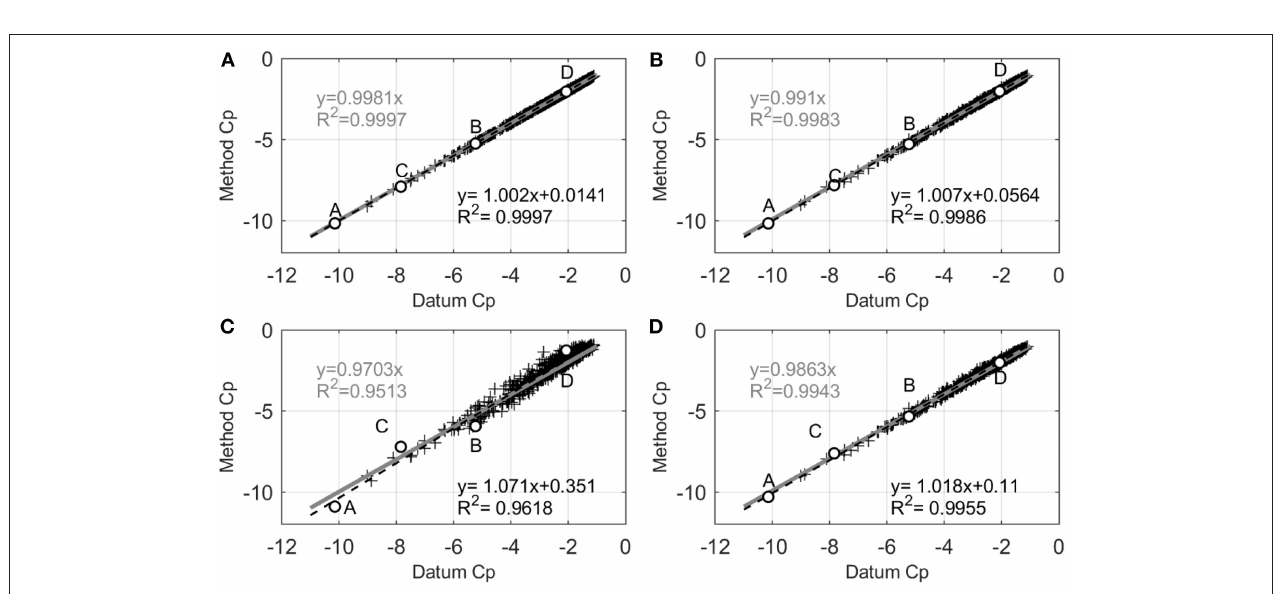
FIGURE 12 | Q-Q plot for each method: (A) EVA N = 16 and T = 10min ( N peak = 11), (B) XIMIS T = 160min ( N peak = 11), (C) YGP T = 60min ( N peak = 30), (D) XIMIS T = 60min ( N peak = 30).